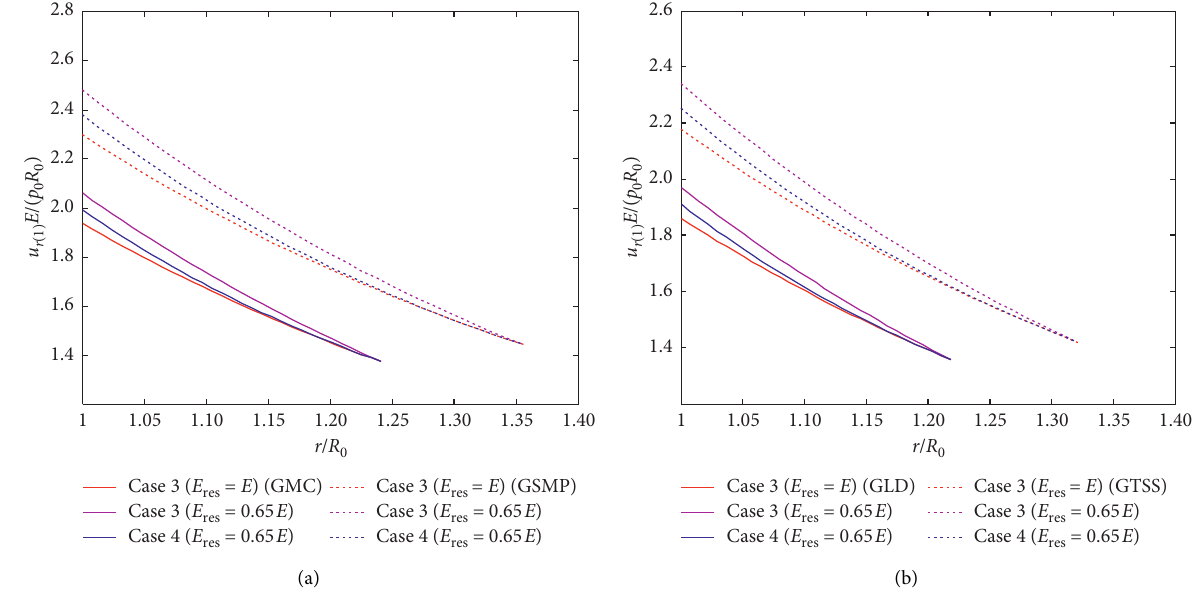
Figure 11: The effect of rock mass damage on the radial displacement. Table 6: The dimensionless surface displacement ( u